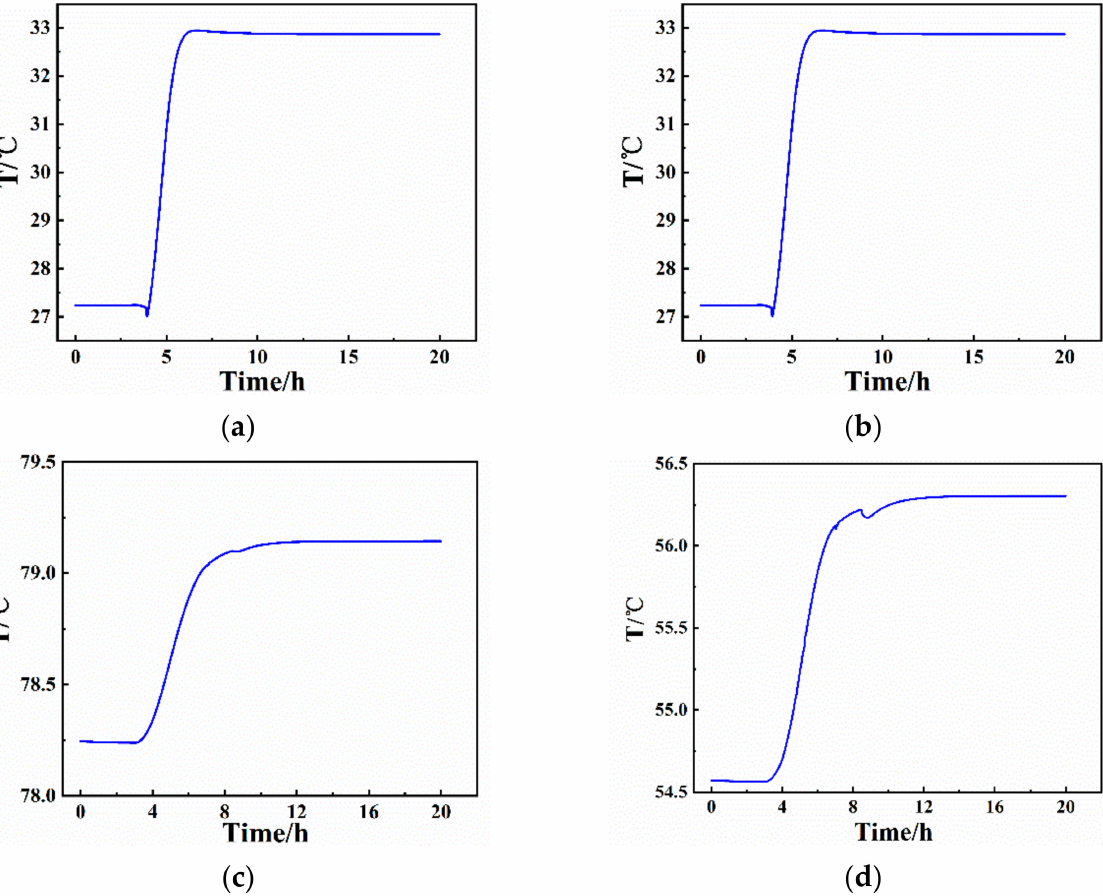
Figure 6. Temperature changes of S8 ( a ), S18 ( b ), S24 ( c ), S32 ( d ).